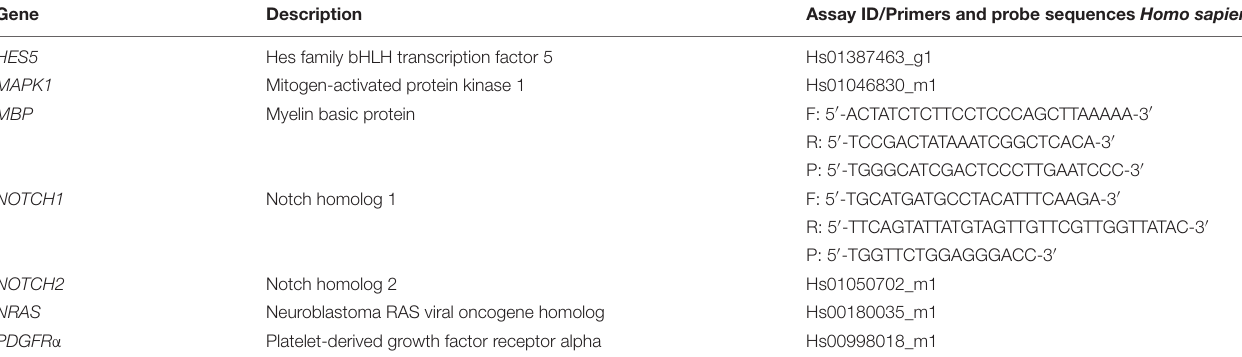
TABLE 1 | Primers and probes or gene expression assays used for real-time RT-qPCR.